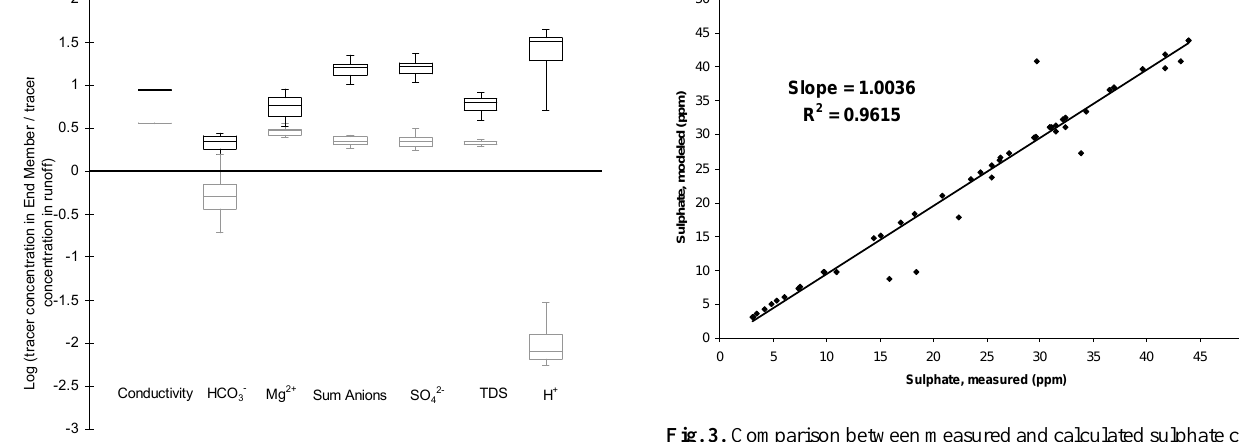
Fig. 3. Comparison between measured and calculated sulphate con- centrations at all mixing points on the Q2 sub-basin.